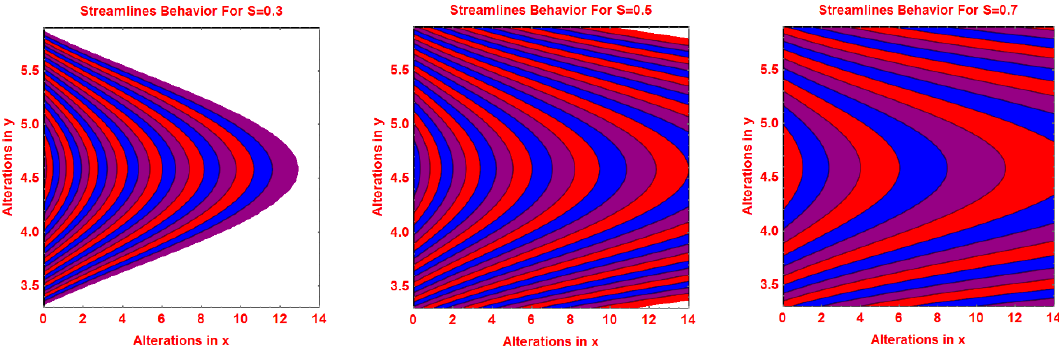
Figure 4. Effects of different values of S on the streamlines pattern.